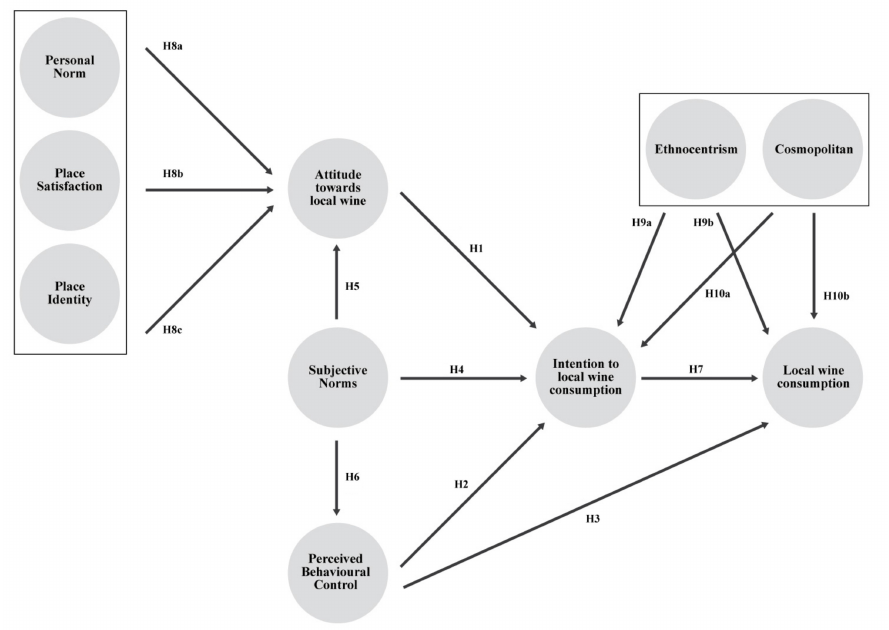
Figure 1. Proposed Theoretical